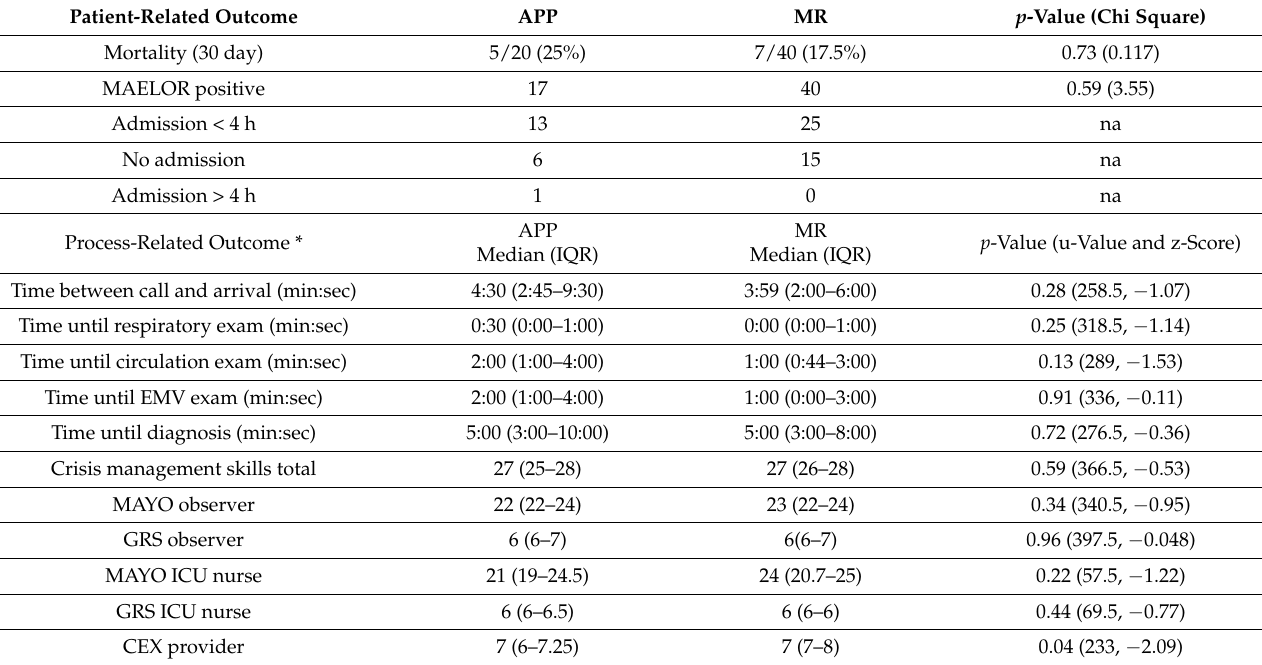
Table 2. Patient- and process-related outcomes of patients treated by either an APP or an